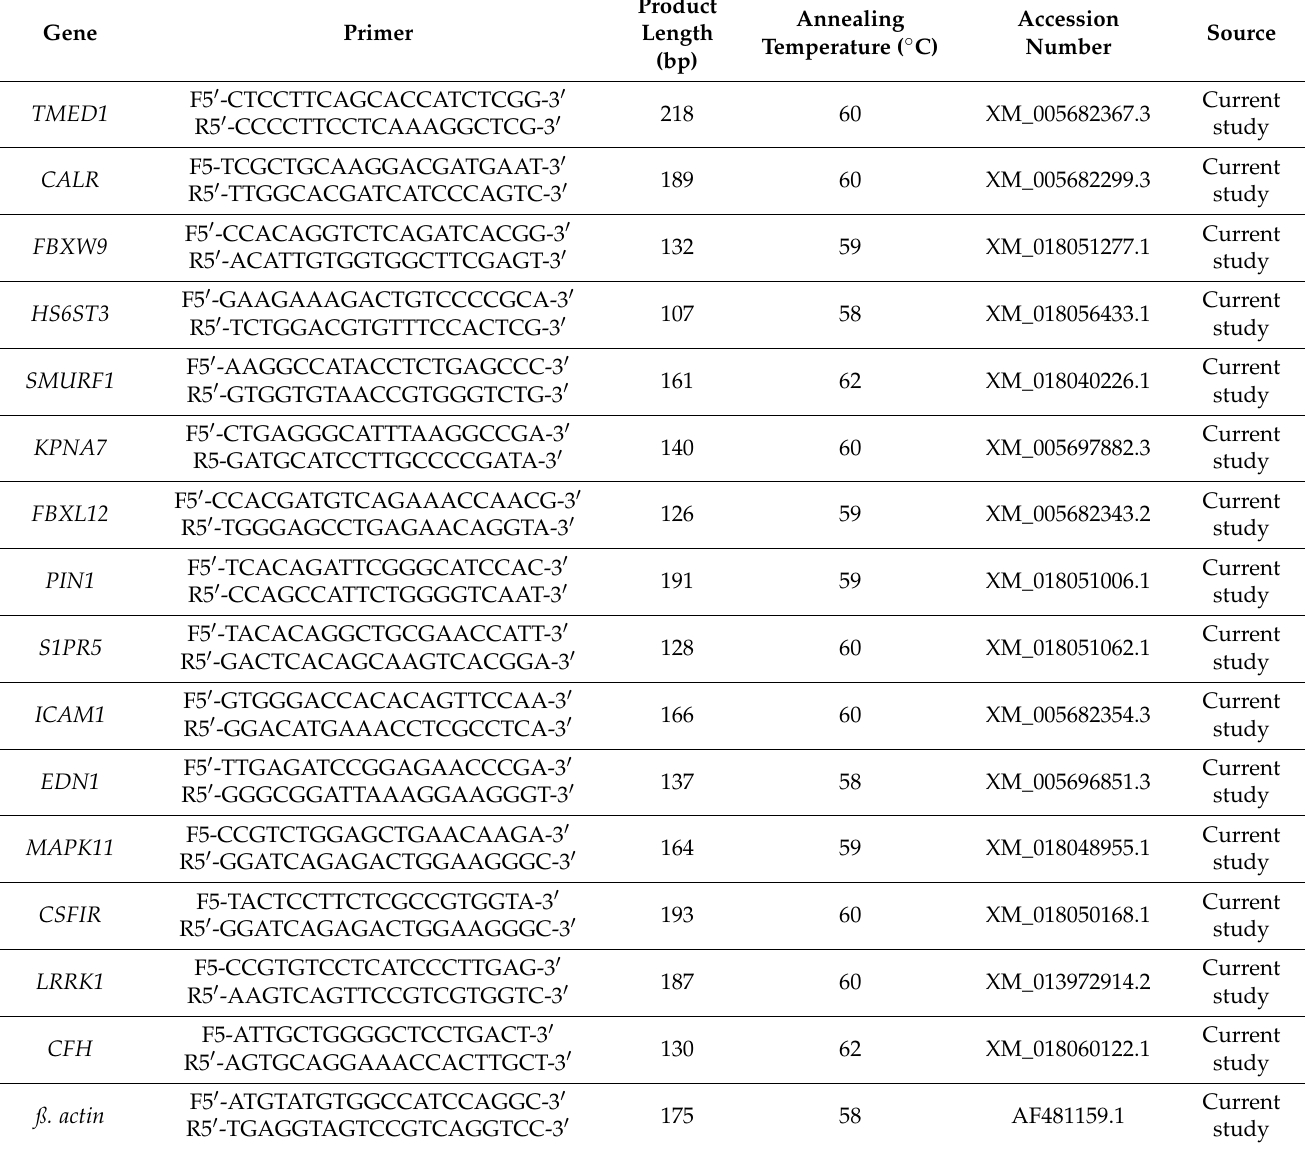
Table 2. Oligonucleotide primers sequence of investigated genes used in real-time